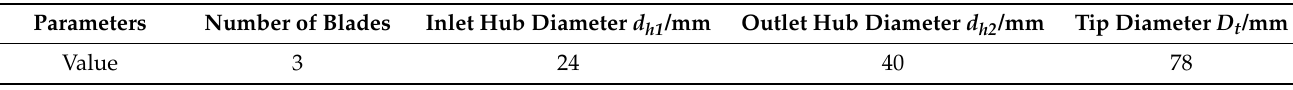
Figure 1. Structure of inducer with helical static blades. Table 1. Main parameters of the